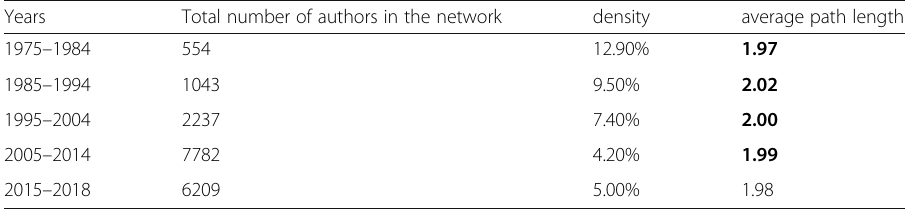
Table 3 Co-citation network density, per decade, 1975-2018